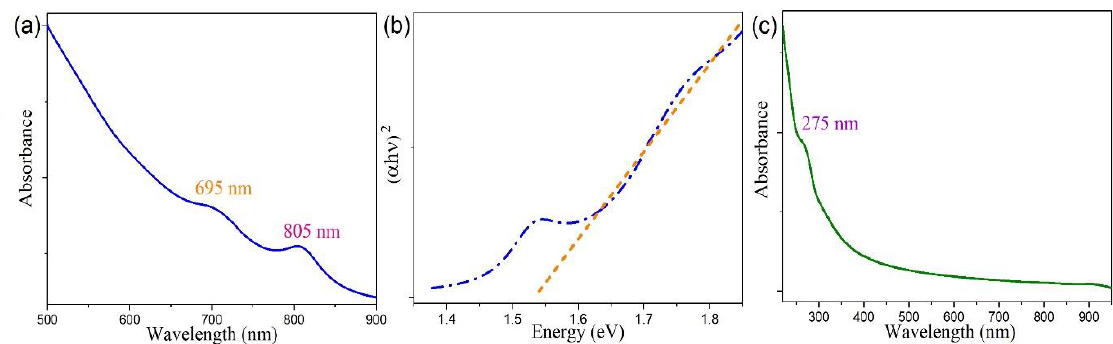
Figure 5. ( a ) Ultraviolet–visible (UV–vis) absorption spectrum of 2D CTAB-MoSe 2 nanosheets clearly reveals characteristic excitonic structures. ( b ) The corresponding plot versus ( ahv ) 2 versus h ν for absorption of 2D CTAB-MoSe 2 , in which the optical band gap energy can be estimated. ( c )